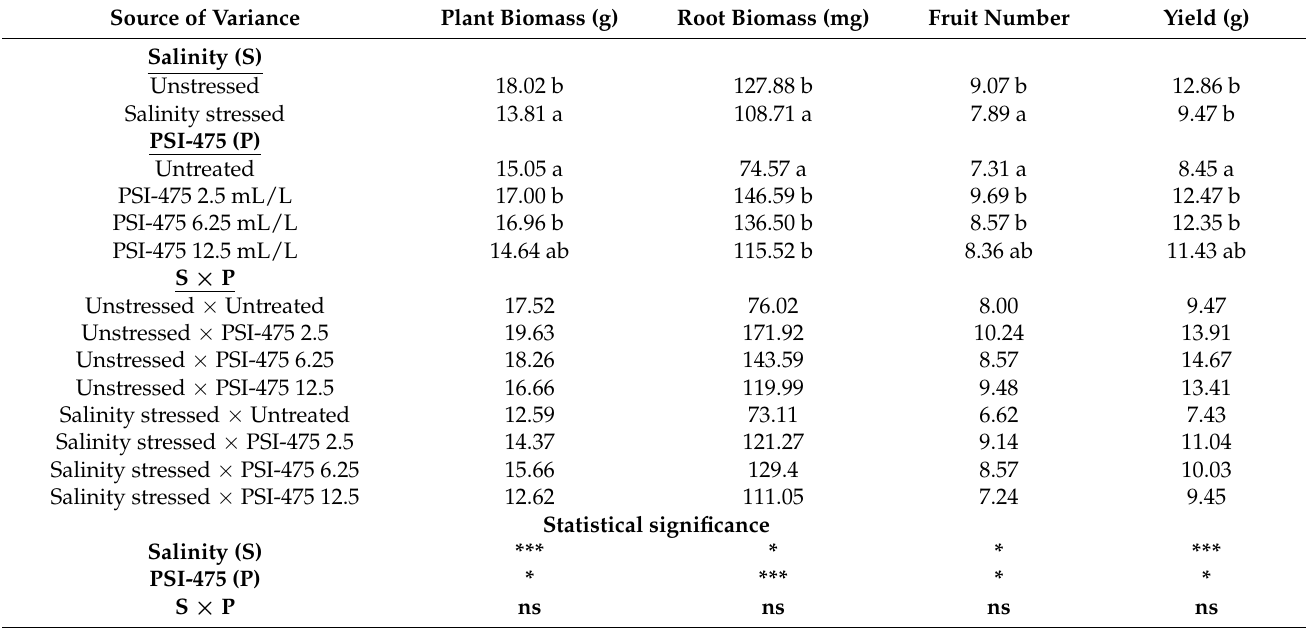
Table 1. Effect of salinity stress and PS1-475 dosage rate on tomato phenotypic and fruit yield parameters at the end of the plant trials.